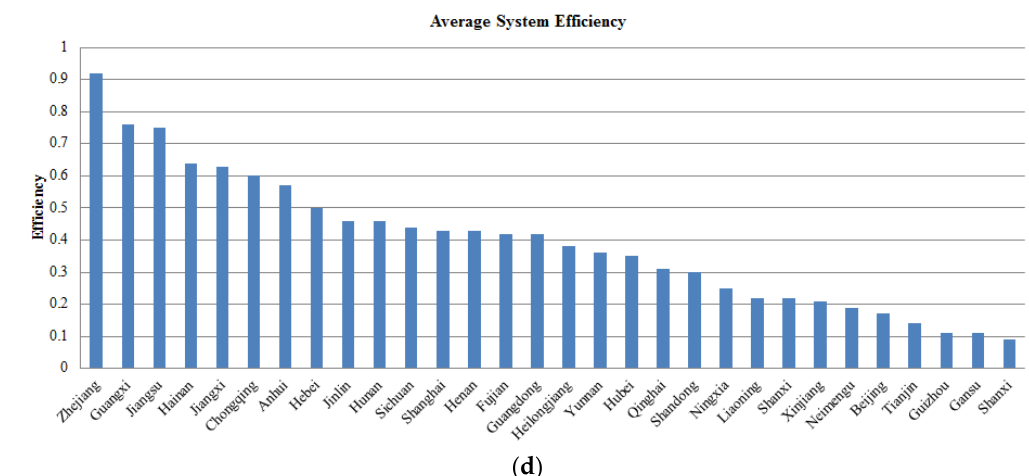
Figure 4. ( a ) System efficiency from 2005 to 2010. ( b ) Average production process efficiency from 2005 to 2010. ( c ) Average treatment process efficiency from 2005 to 2010. ( d ) Average system efficiency from 2005 to 2010.